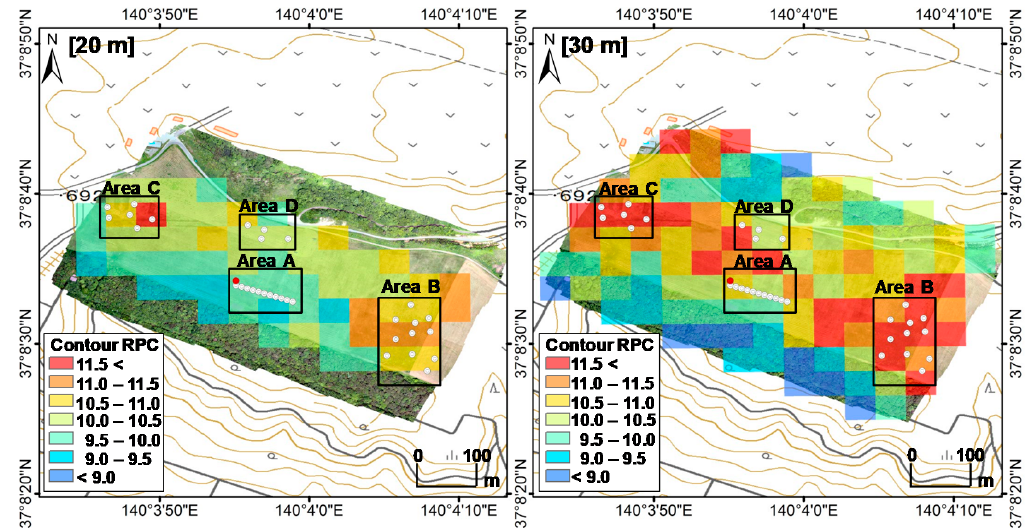
Figure 6. Maps of the averaged RPCs (50 m × 50 m mesh) obtained via ARM at 20 and 30 m agl.